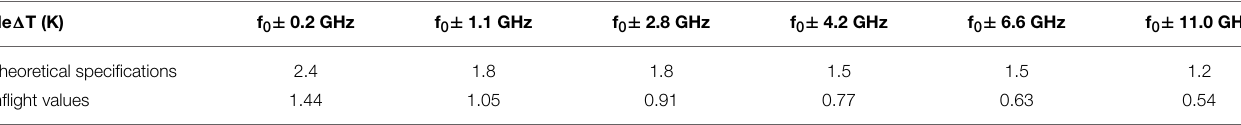
TABLE 2 | Characteristics of